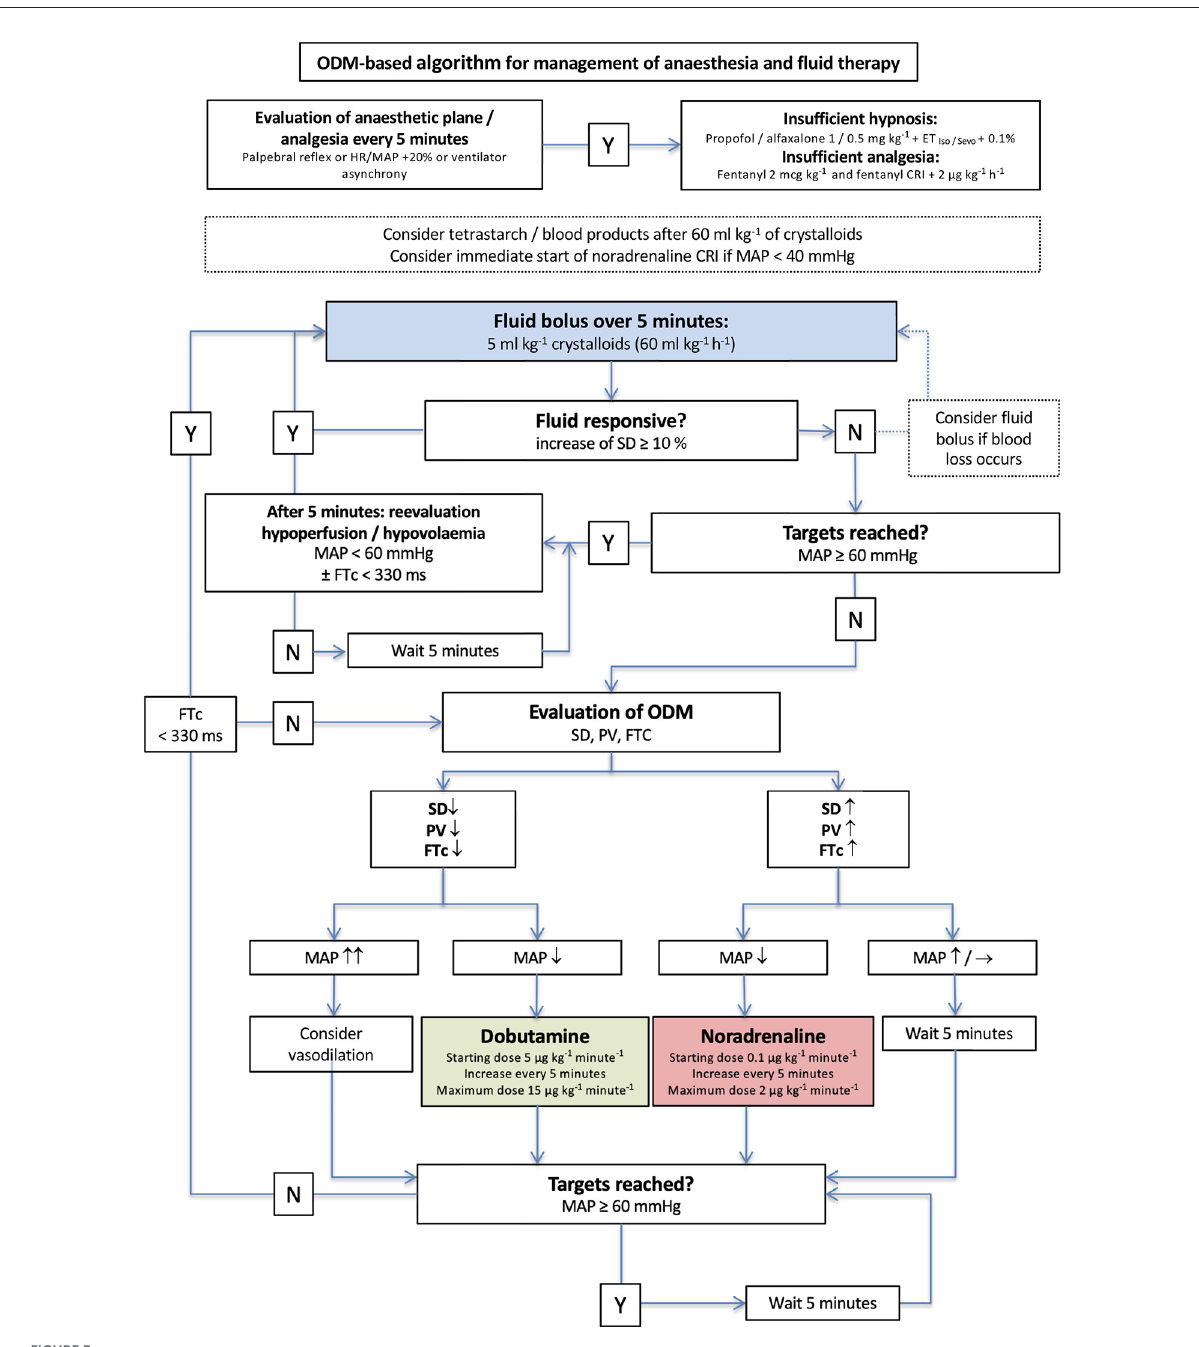
FIGURE3 Algorithm for management of anesthesia and goal-directed fluid therapy in group esophageal Doppler monitor (EDM). The initial crystalloid bolus of 5 ml/kg was administered to every dog. Y, yes; N, no; iso, isoflurane; sevo, sevoflurane; IV, intravenous; CRI, continuous rate infusion; bpm, beats per minute.